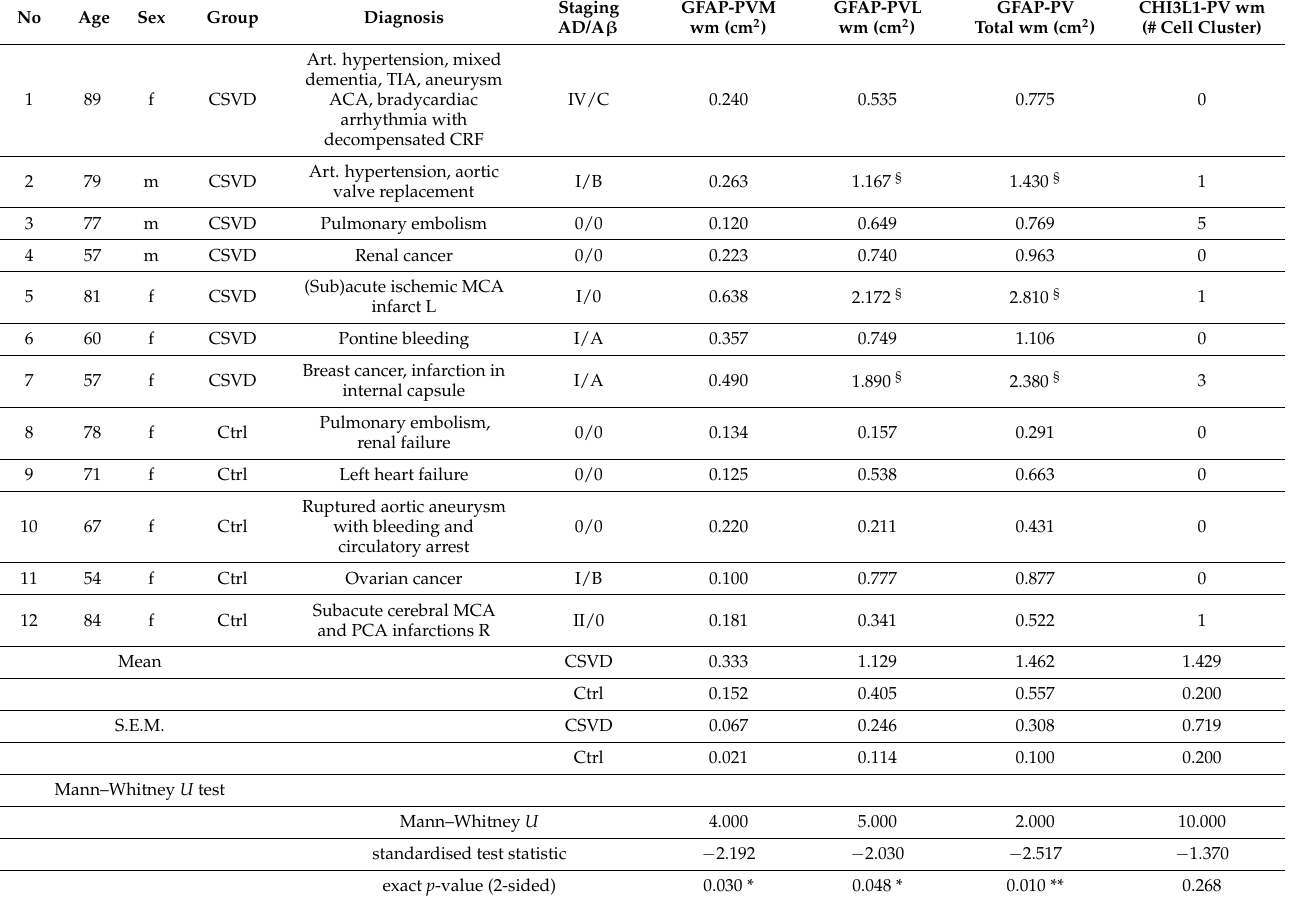
Table 2. GFAP and CHI3L1 immunoreactivity in the periventricular white matter in CSVD cases and the controls. Quantitative histopathological analyses of the white matter (wm) area with enhanced GFAP expression (area measured in cm 2 ) and with CHI3L1-positive cell clusters (number within a 10-mm radius) around the central part of the lateral ventricle at the mid-hemispheric level. In CSVD cases, the medial periventricular zone (PVM) with strong GFAP expression extends much further into the lateral periventricular zone (PVL), with moderate enhancement of the GFAP expression when compared to the controls. Moreover, enhanced GFAP expression in the PVL of some CSVD cases extends farther to the deep white matter, often reaching the cortex of the superior frontal gyrus (§). ACA = anterior cerebral artery; Art. = arterial; Ctrl = control; CRF = chronic renal failure; CSVD = cerebral small vessel disease; f = female; m = male, L = left; MCA = middle cerebral artery; mm = millimetre; PCA = posterior cerebral artery; PV = periventricular region; PVL = lateral periventricular region; PVM medial periventricular region; R = right; Staging AD/A β = staging for Alzheimer-related neurofibrillary tangles/A β deposits [24]; TIA = transient ischaemic attack; wm = white matter. * p < 0.05, ** p ≤ 0.01.